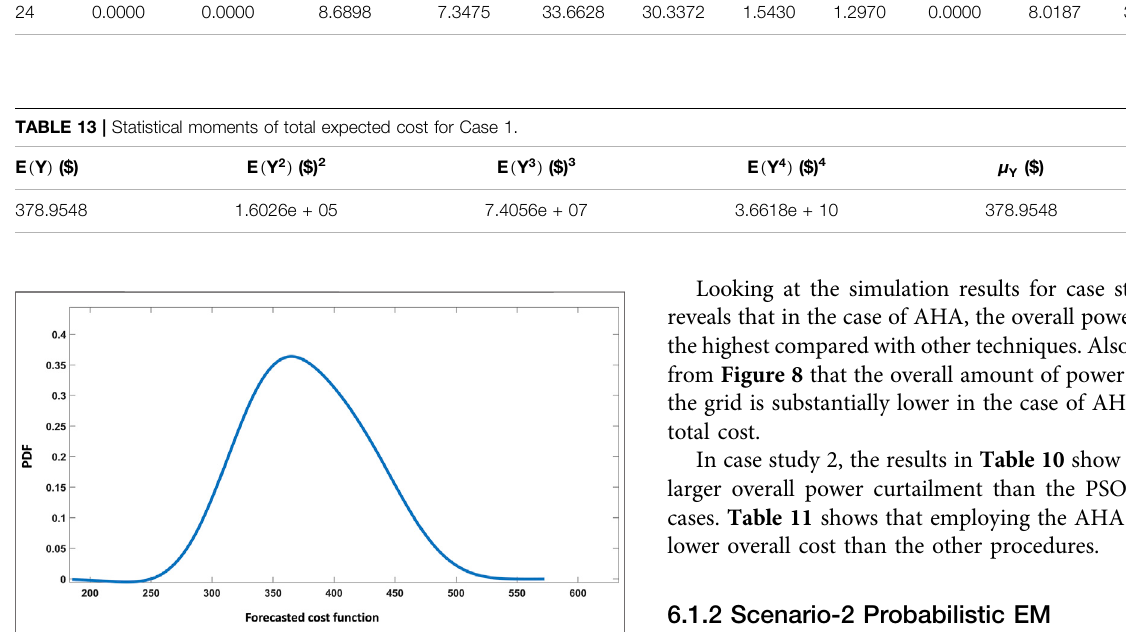
Frontiers in Energy Research |